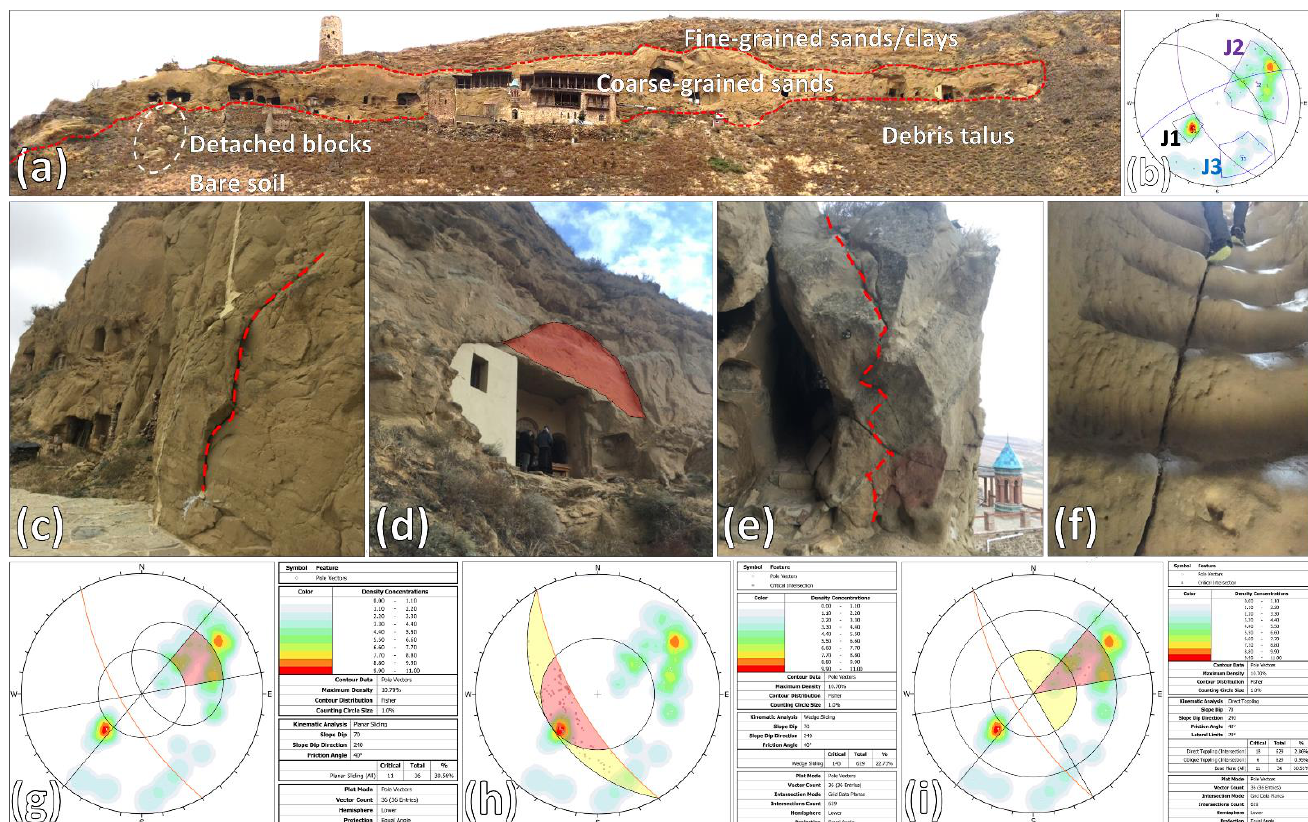
Figure 10. Outcomes of the field surveys in the Natlismcemeni monastery: local geological features ( a ) and structural discontinuities ( b ). Main instability phenomena detected in the field surveys and corresponding 2D kinematic analysis: planar ( c , g ) and wedge ( d , h ) failures; topples ( e , i ). Open fracture ( f ).